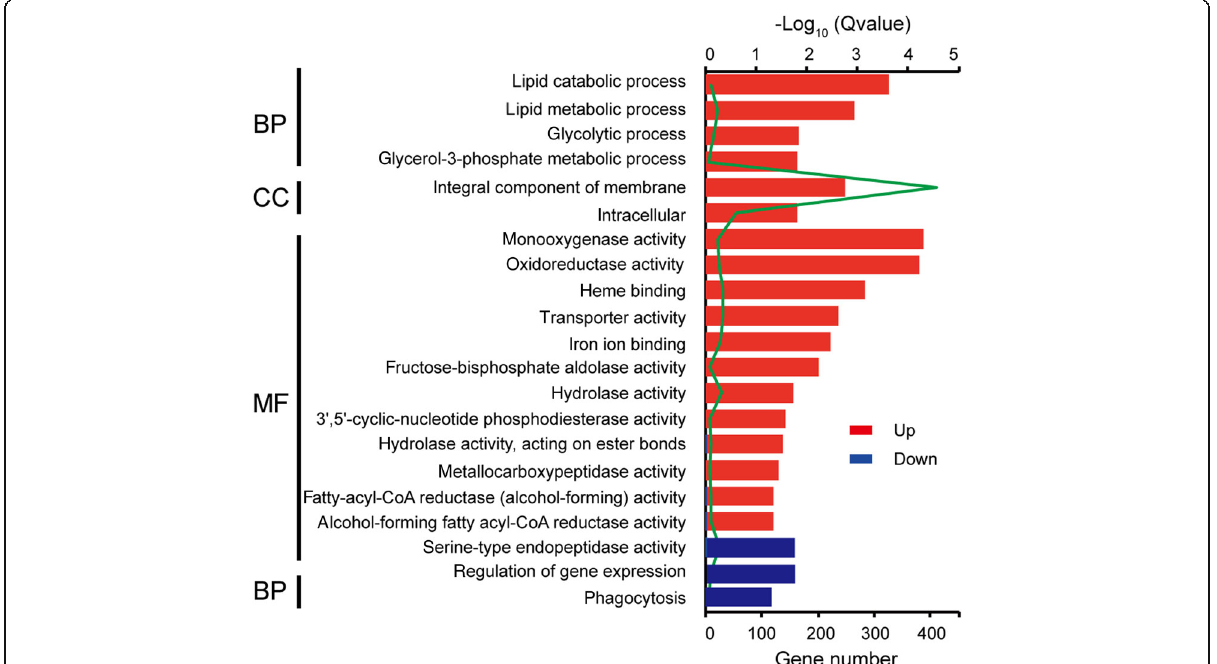
Fig. 4 GO enrichment of the DEGs. GO enrichment of up- and down-regulated DEGs were performed separately. BP, biological process; CC,